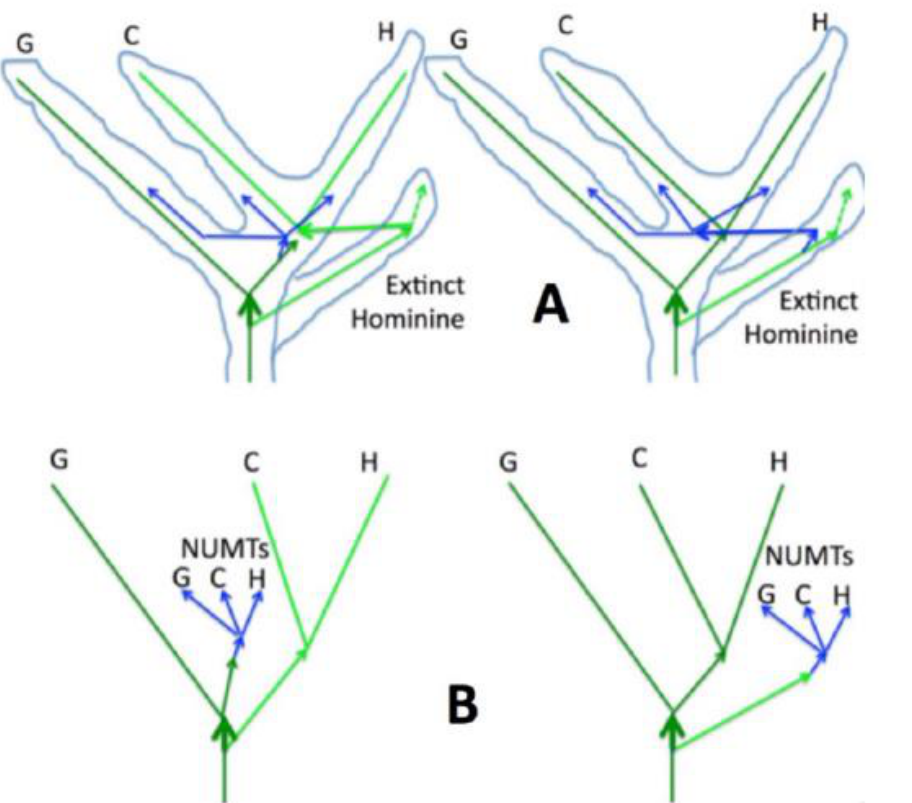
Figure 5. Comparison of the NUMT transfer ( right ) and the mtDNA introgression ( left ) scenarios of hybridization. Panel ( A ) represents the inferred events, Panel ( B ) represents the resulting observed phylogenies. Blue arrows represent the NUMTs, and light blue lines depict the superposition of the phylogenetic trajectories of all the nuclear genetic loci, as in Figure 1B. The mtDNA genealogies are green. Horizontal arrows represent introgression of mtDNA (green) or transfer of the NUMT locus between extinct hominine and the HCG mitochondrial (blue). Extinct hominine mtDNA lineage is neon green, the HCG mtDNA lineage is forest green.